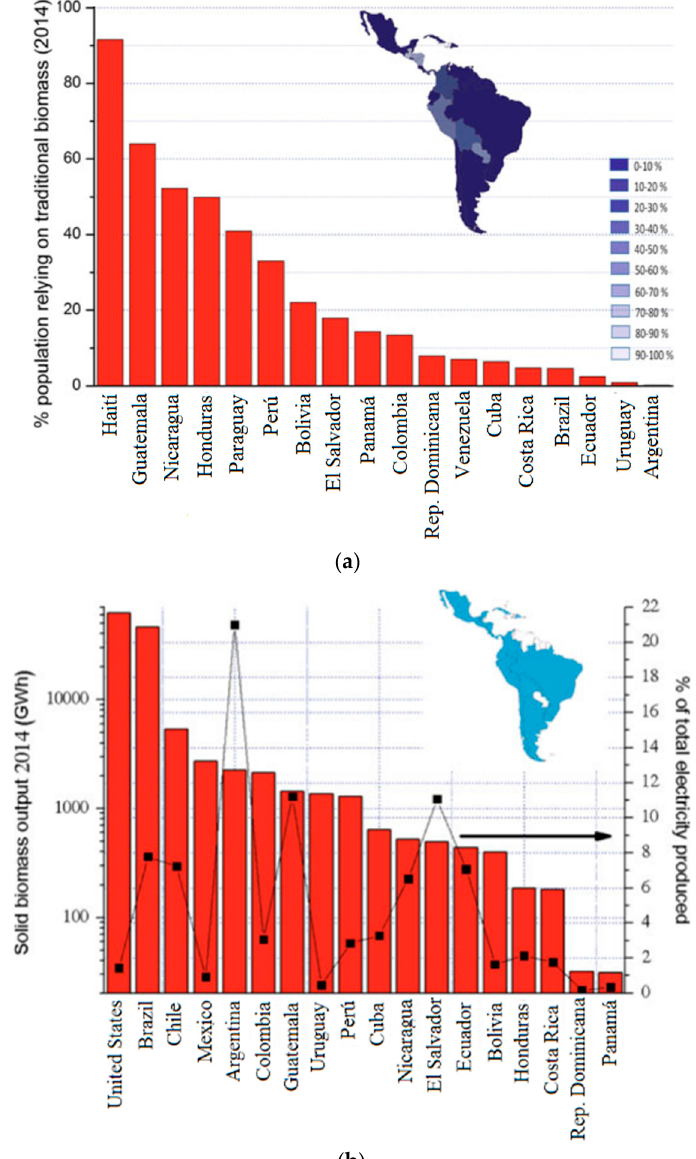
Figure 5. ( a ) Percentage of the population relying on traditional biomass in Latin America in 2014 [112], and ( b ) electricity output from biomass and shared total electricity produced in different Latin American countries in 2014 [112].